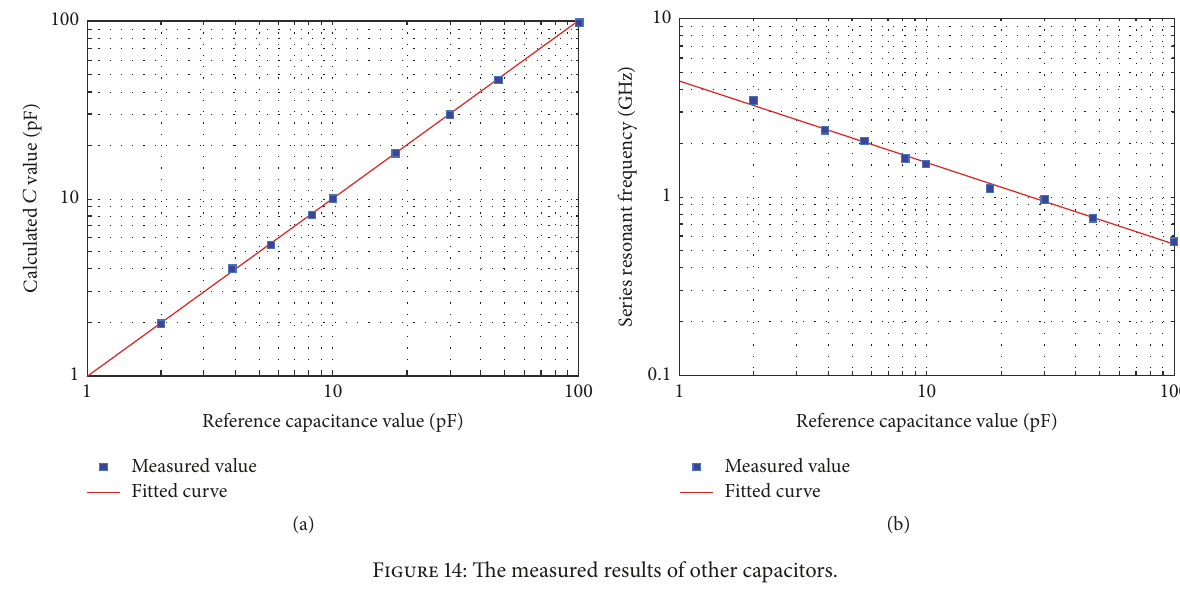
Figure 14: The measured results of other